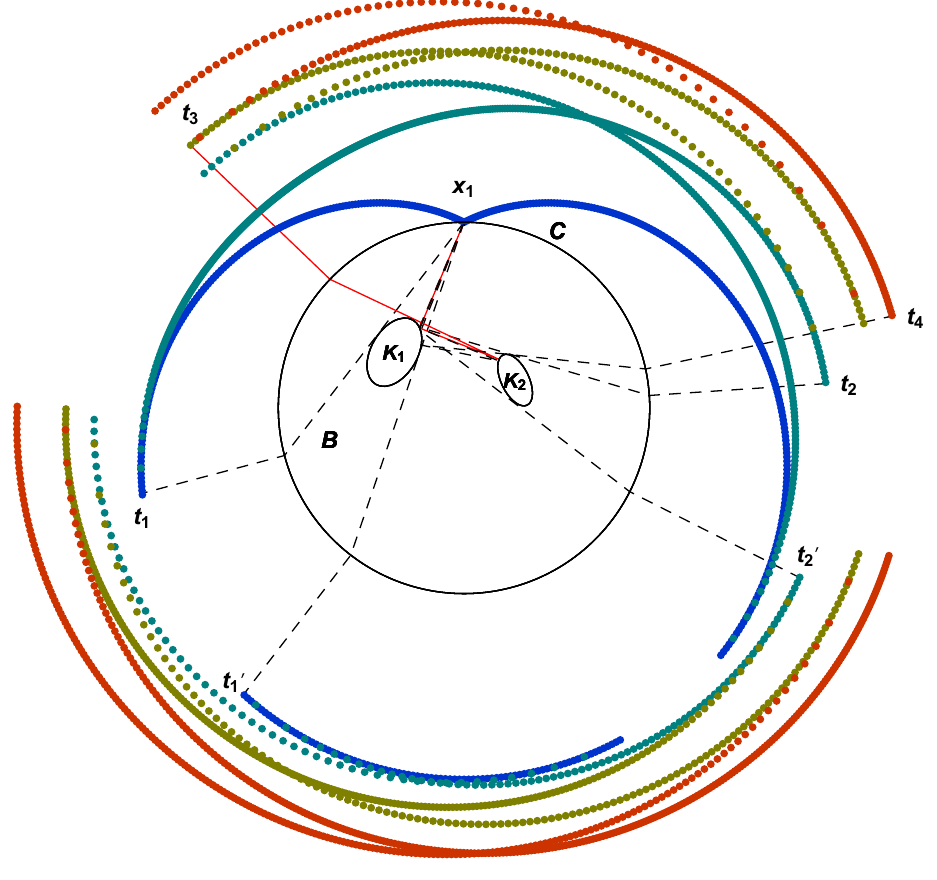
Figure 2. More of the echograph in Example